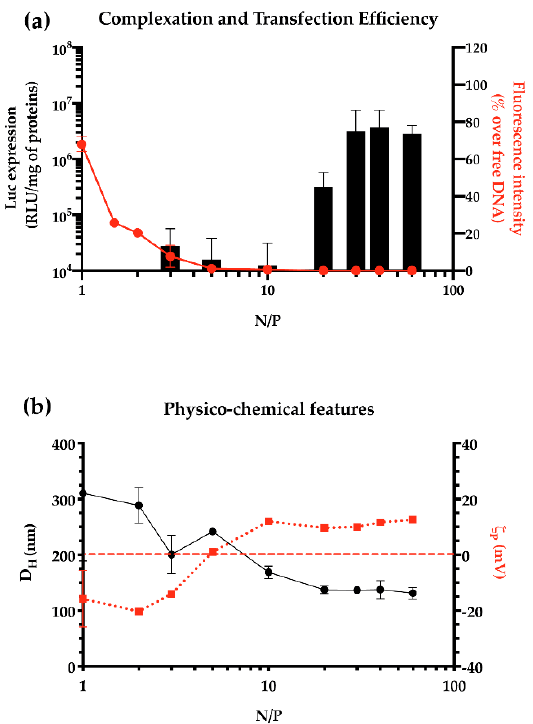
Figure 3. DNA complexation ability, transfection efficiency, and physico-chemical characteristics of pDNA/ l PEI complexes prepared in 10 mM Hepes at different N/Ps. ( a ) Transfection efficiency (black bars) in L929 cells of pDNA/ l PEI complexes prepared at different N/Ps. Results are expressed as luminescence signal (RLU) normalized to the total protein content in each cell lysate, and the DNA complexation ability of l PEI (red dots, solid line), evaluated by monitoring the fluorochrome exclusion from complexes as a function of the N/P. ( b ) Mean hydrodynamic diameter (D H , black dots solid line) and overall surface charge ( ζ P , red squares and dotted line) of pDNA/ l PEI complexes at different N/Ps, as measured by dynamic light scattering (DLS) and electrophoretic light scattering (ELS), respectively. Results are expressed as mean ± SD ( n ≥ 3).